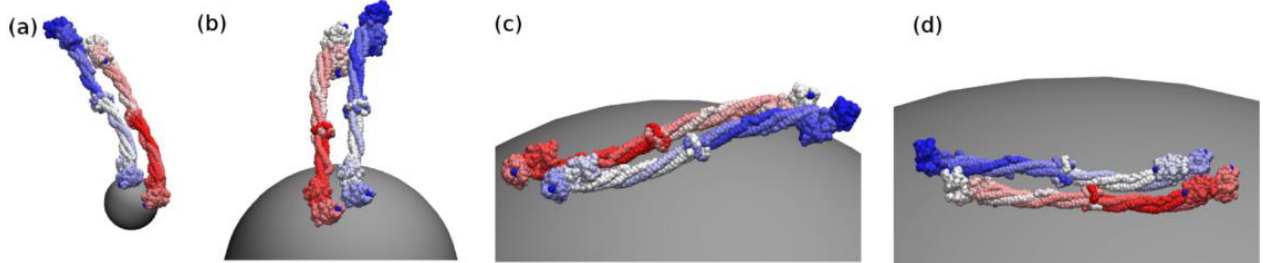
Figure 5. Orientations of fibrinogen (FG) adsorbed onto a neutral nanoparticle of radius ( a ) 5, ( b ) 20, ( c ) 50, and ( d ) 100 nm. Reproduced with permission from [42], American Institute of Physics, 2015.